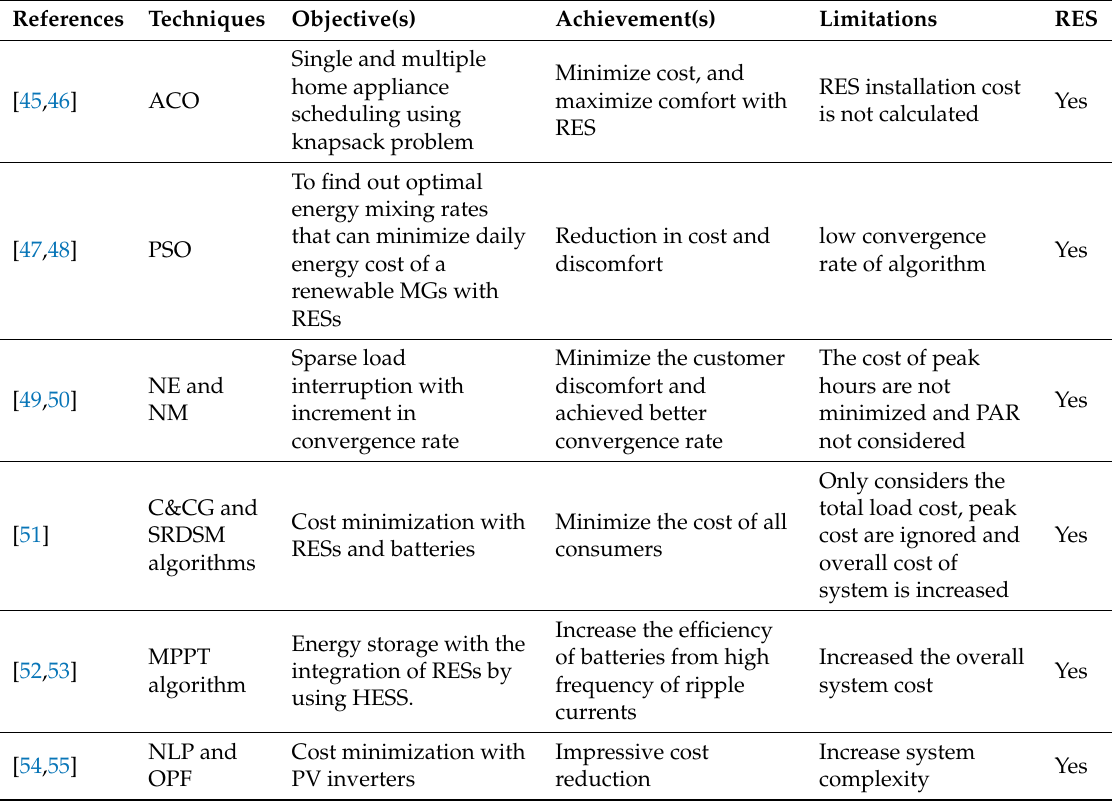
Table 2. Summarized literature work for distributed energy